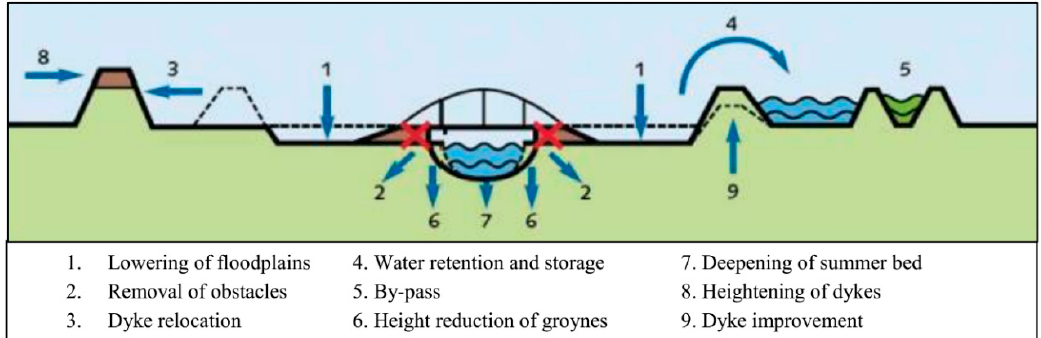
Figure 2. Measures applied to create more room for river in the Room for the River program. Adapted from [13].